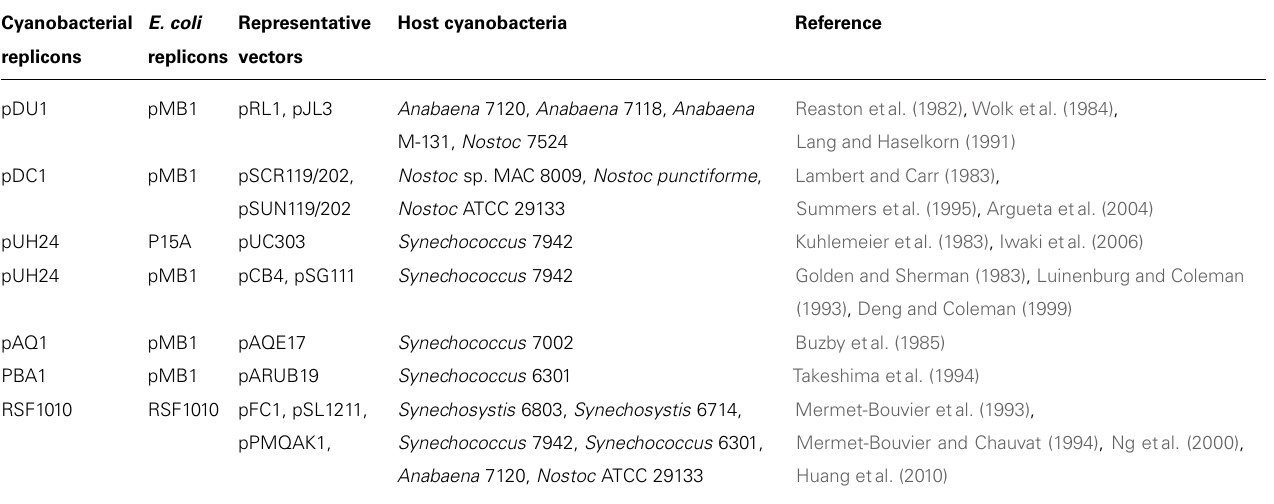
Table 2 | Representative shuttle vectors for